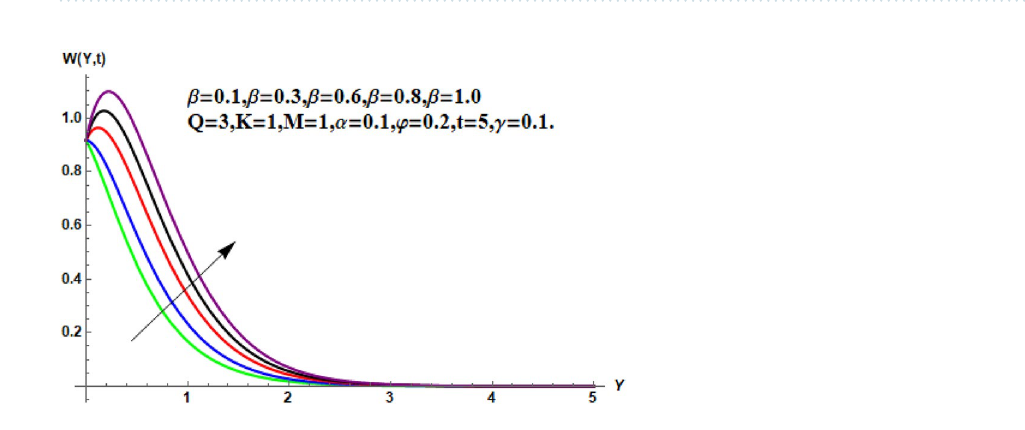
Figure 6. Velocity profile for different values of β .